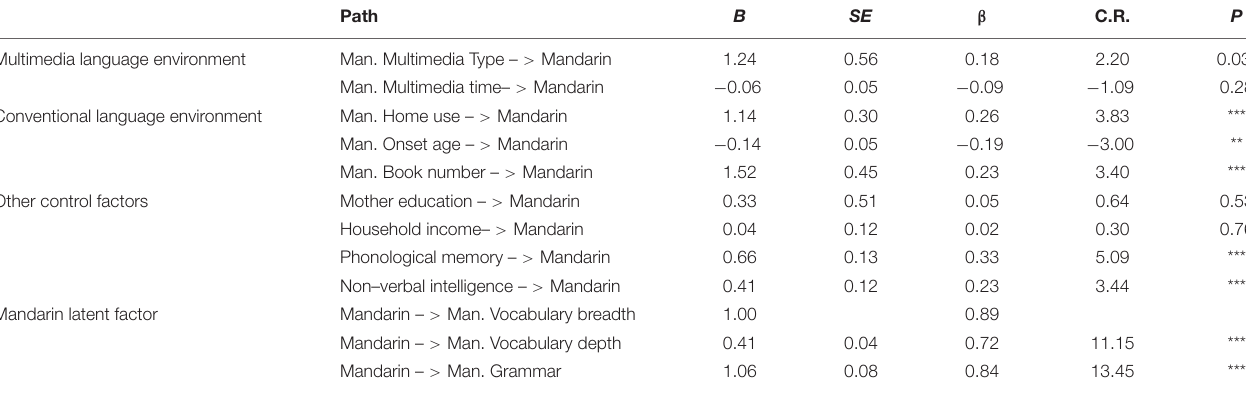
TABLE 2 | Results of structural equation modeling on Mandarin language outcomes.